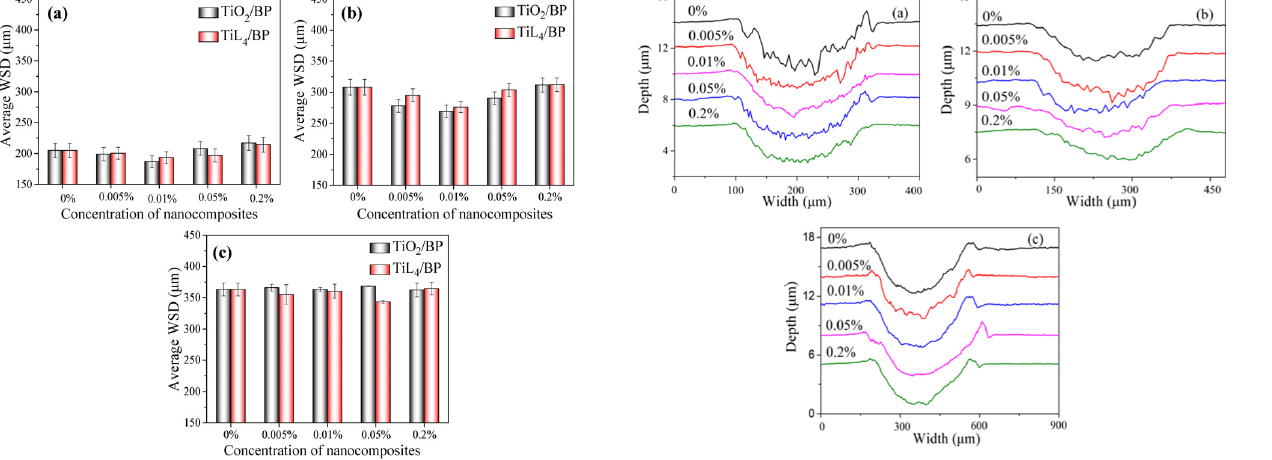
Fig. 7 Wear profiles of the lower disk lubricated by PAO6 containing or without TiO 2 /BP nanocomposites under different loads: (a) 8 N, (b) 20 N, and (c) 30